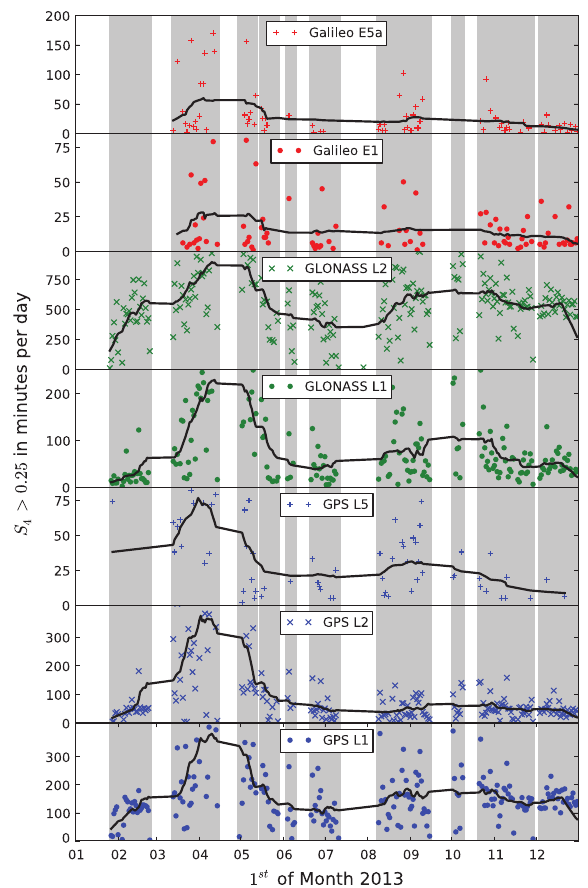
Figure 4. Amount of scintillation events over the course of the year 2013. The symbols are the accumulated time in minutes of scintillations per day for the respective signal. The black lines show a moving average. The gray shaded area marks the data